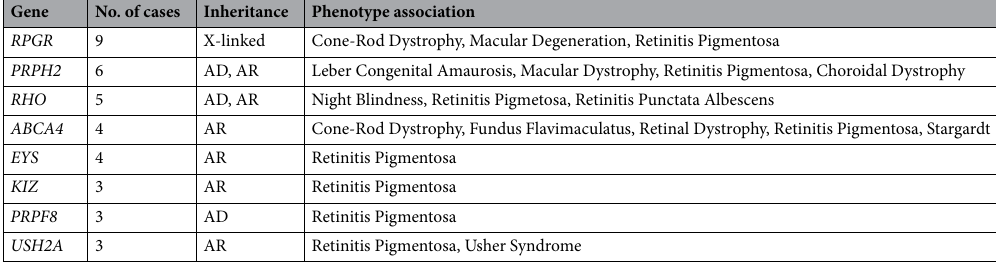
Table 2. Most frequently identified genes in the dataset (by number of families).